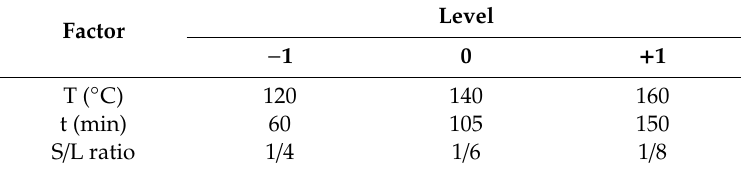
Table 1. Factors and levels of the 2 2 factorial design for the first set of extraction runs.